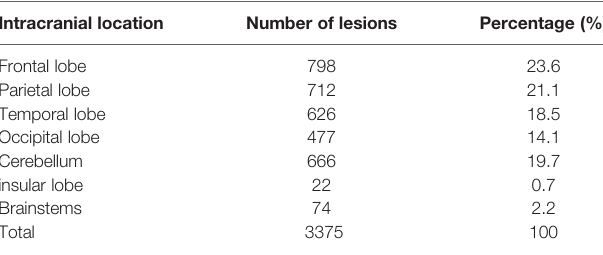
TABLE 2 | The distribution of metastatic lesions by intracranial location ( n =